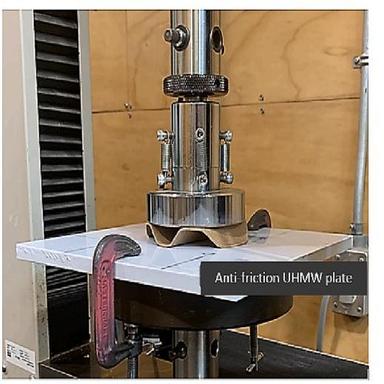
Flat compression test with the use of a UHMW anti-friction plate.